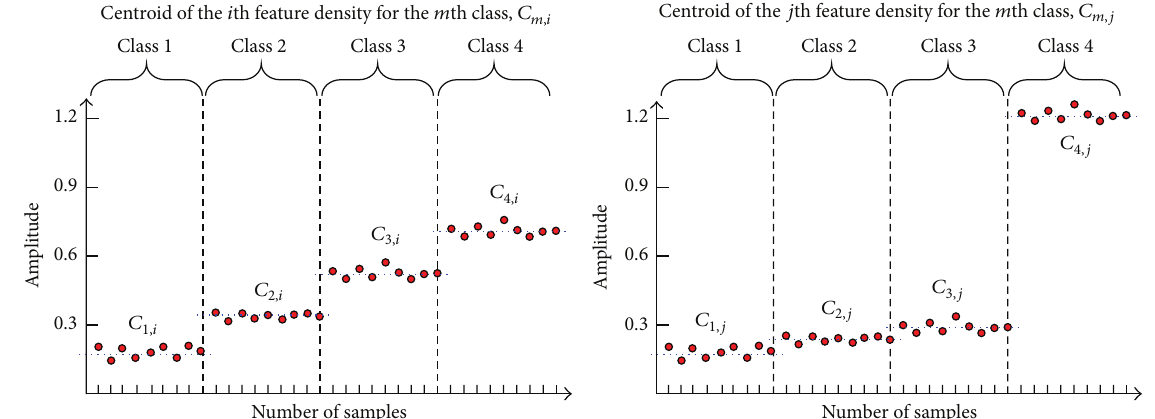
Figure 6: Examples of the 𝑖 th and 𝑗 th fault signature distribution per class with the assumption that these features have the same degrees of the intraclass compactness.